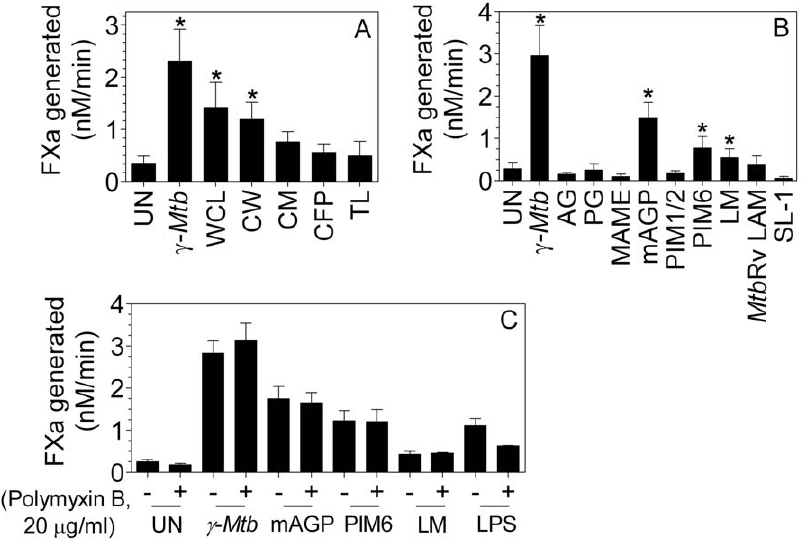
Figure 7. Mycobacterial mAGP, PIM6 and Lipomannans are the potential players in inducing TF in macrophages. ( A ) MDMs were treated with various mycobacterial subcellular fractions, whole cell lysate (WCL), cell wall (CW), cell membrane (CM), culture filtrate protein (CFP) and total lipids (TL), all at 50 m g/ml concentration for 9 h. * denotes significant difference compared to untreated control cells (P , 0.05) ( B ) MDMs were treated with various mycobacterial purified components such as arabinogalactan (AG), peptidoglycan (PG), mycolic acid methyl esters (MAME), mycolyl arabinogalactan peptidoglycan complex (mAGP), phosphatidylionositide mannoside 1,2 and 6 (PIM1/2 and PIM6), lipomannan (LM) and lipoarabinomannan from H37Rv (LAM Rv) and sulfolipid (SL-1), all at 50 m g/ml concentration for 9 h. * denotes significant difference compared to untreated control cells (P , 0.05); paired t-test ( C ) MDMs were treated with mAGP, PIM6, LM in presence and absence of polymyxin B (10 m g/ml). As a positive control for polymyxin B effect in neutralizing endotoxin, MDMs were treated with LPS (100 ng/ml) 6 polymyxin B. Cell surface TF activity was determined in factor X activation assay. Data are mean 6 SEM (n=4–6).